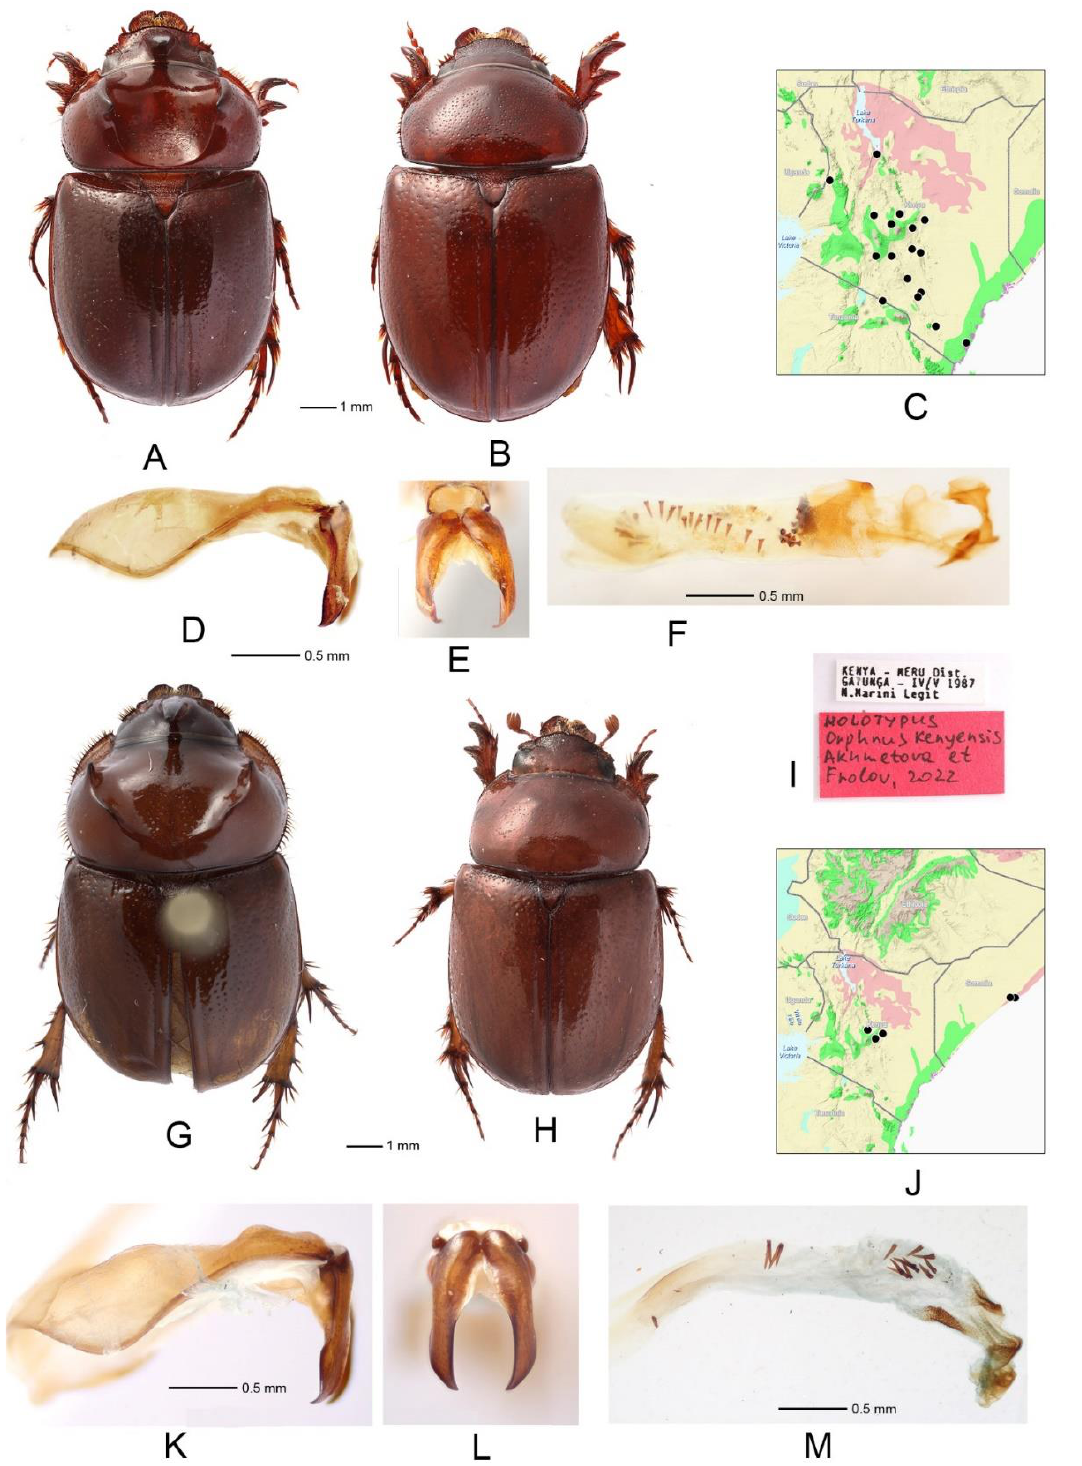
Figure 2. Orphnus macleayi Laporte de Castelnau, 1832 ( A – F ) and O. kenyensis Akhmetova et Frolov, sp. nov. ( G – M , ( G , I , K – M, holotype)). ( A , G ) male, habitus; ( B , H ) female, habitus; ( D , K ) aedeagus in lateral view; ( E , L ) parameres in dorsal view; ( F , M ) endophallus; ( I ) labels; ( C , J ) distributional record map. (Figure 2B; as opposed to being slender, cylindrical in the latter species), and larger number record of spinules of the endophallus (Figure 2F).